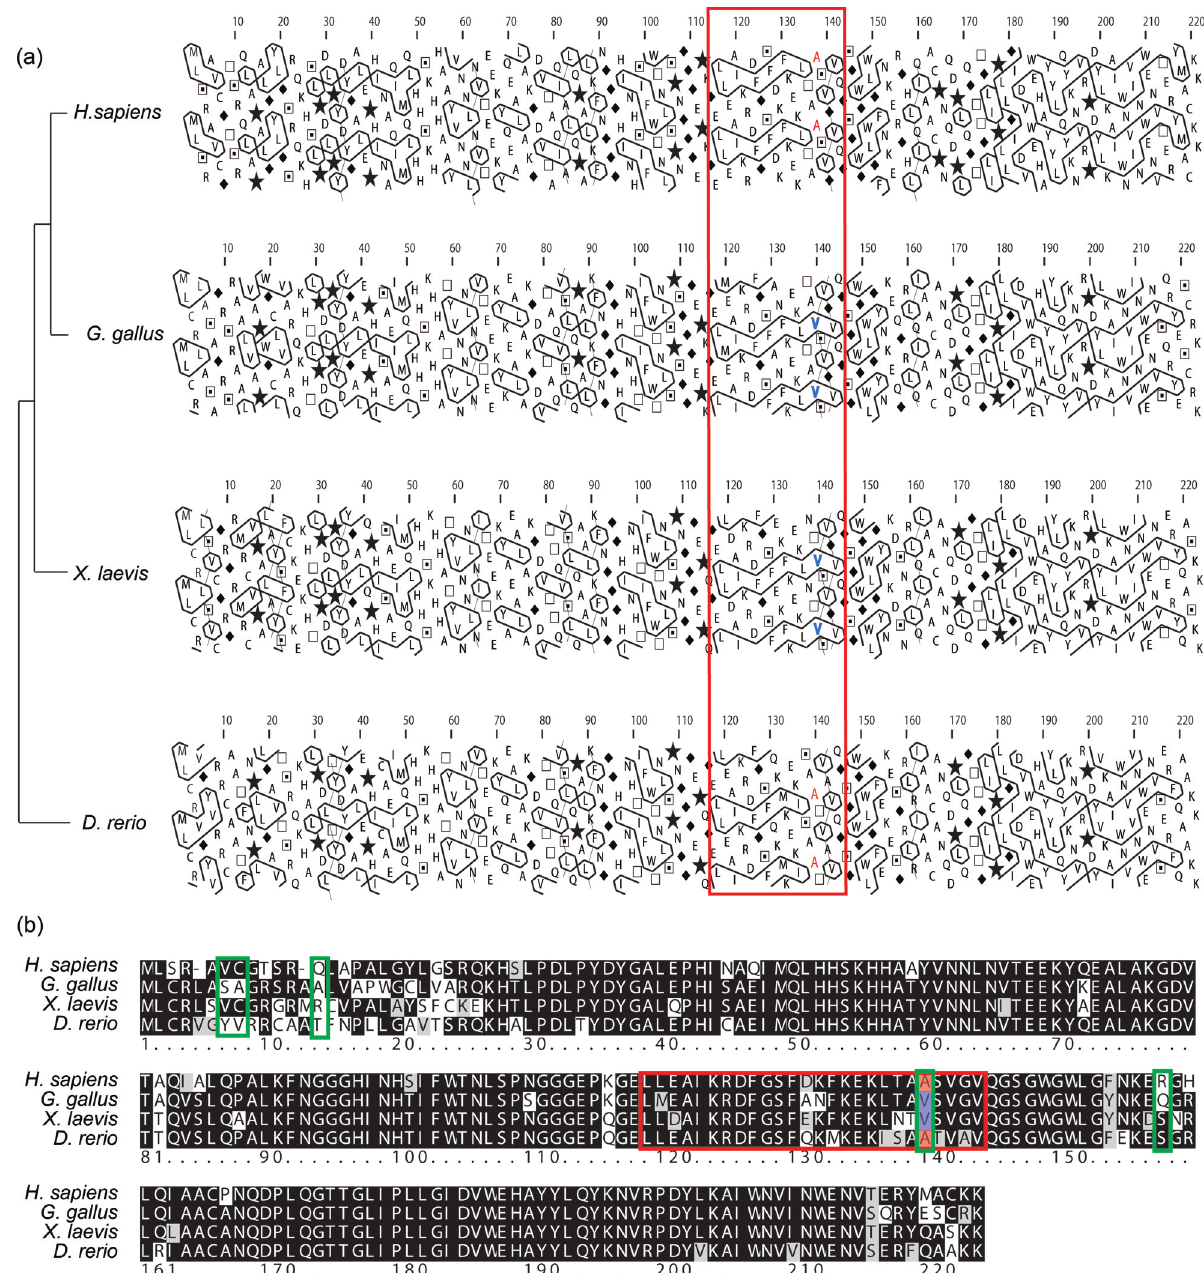
Figure 2 - Comparison of the HCA structure and amino acid sequence of four vertebrates MnSODs. Note: The similarity in HCA between fish ( D. rerio ) andman( H.sapiens ).(A)HCAplotofMnSOD.TheverticalredboxshowsaregionofsignificantdifferencesbasedonHCA.Aminoacidchangesresult- ing in changes in the HCA plot are in red (hydrophilic) or blue (hydrophobic). The phylogram to the left indicates the likely evolutionary relationship of the taxa in order to compare with changes in hydrophobicity. (B) Amino acid sequenced alignment of MnSOD. The black background shows regions where two or more amino acids are totally identical, while the gray background indicates changes resulting in similar amino acids. The positions in red (hydrophilic) or blue (hydrophobic) background show changes in hydrophobicity. The red horizontal box encloses a region corresponding to the regions enclosed by the vertical box in A. The green boxes enclose the positively selected residues detected by PAML in Table